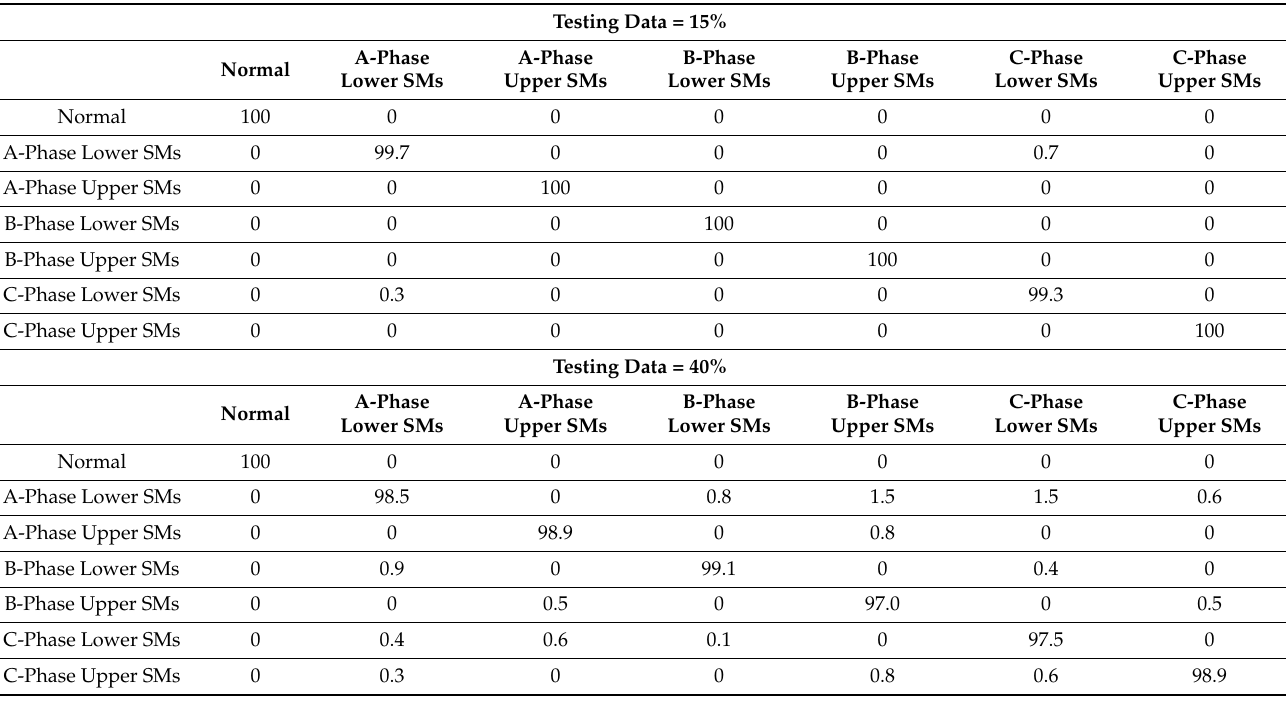
Table 5. Sample confusion matrix of the classification results of SVM-based ECOC with data normali-